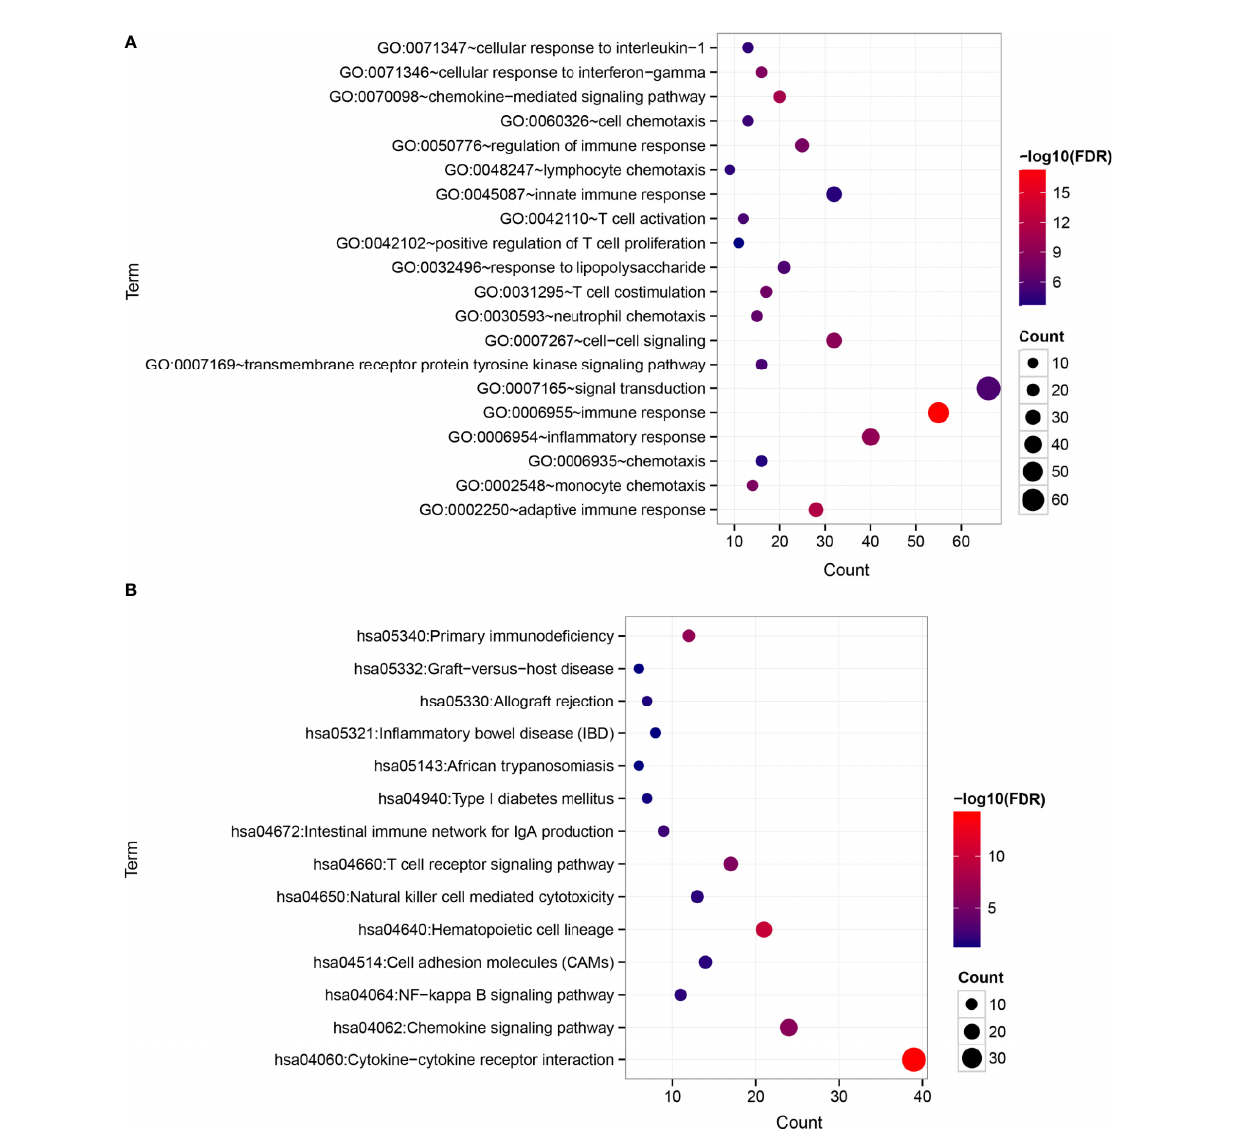
FIGURE 7 | Differences in functional pathways between the risk groups. (A) Biological processes (BP). (B) KEGG signaling pathways. The horizontal axis represents the number of signi fi cantly differentially expressed genes, the vertical axis represents the item name, the size of the dots represents the number of DEGs, the color of the dots represents the enrichment signi fi cance, and the closer the color is to red, the higher the signi fi